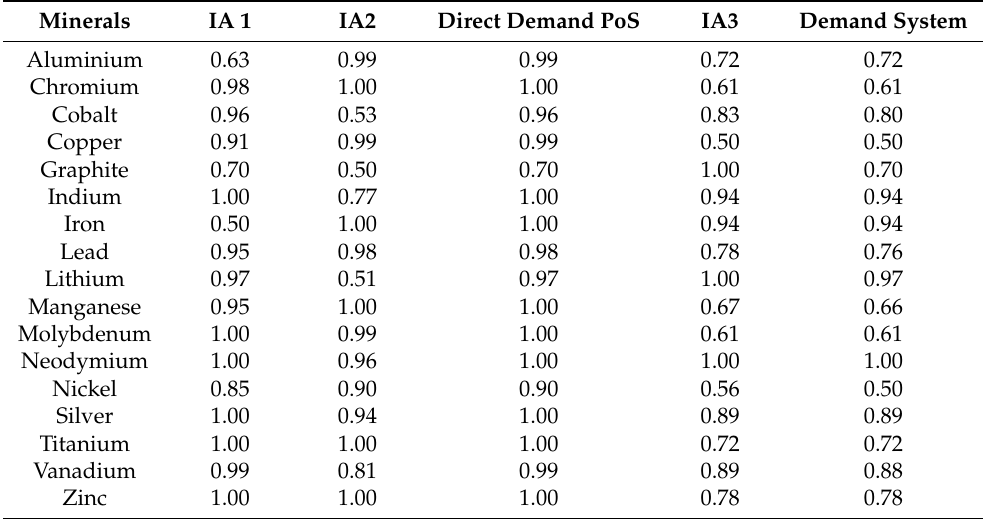
Table 5. Result of calculation of intermediate levels of demand system in Scenario 2 fuzzy model.